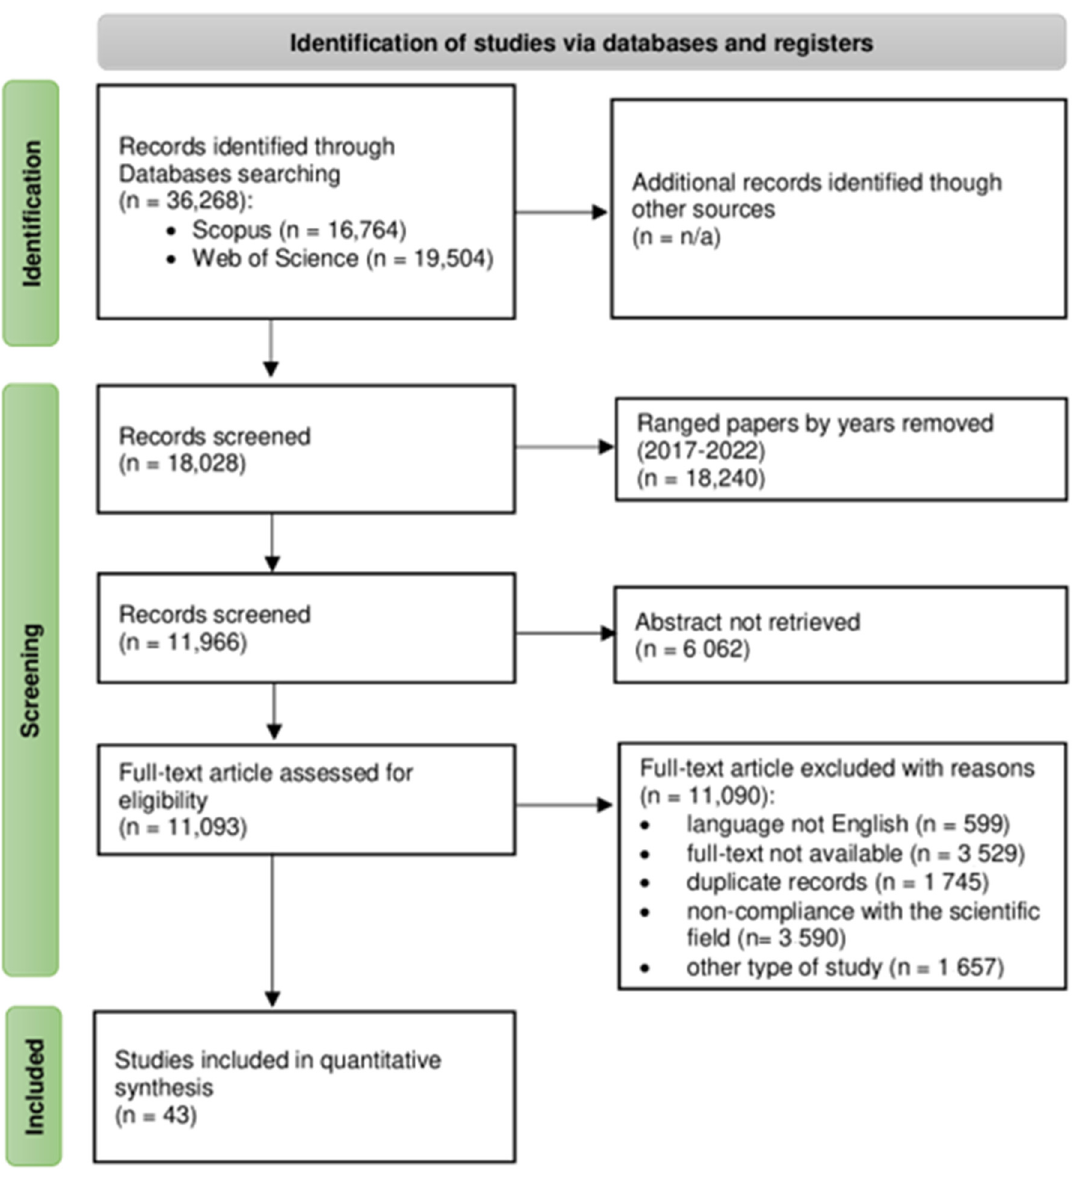
Figure 1. The PRISMA flow diagram for systematic reviews, which included TITLE-ABS-KEY (recommendation AND system AND education) search results of Scopus and Web of Science da- tabases.